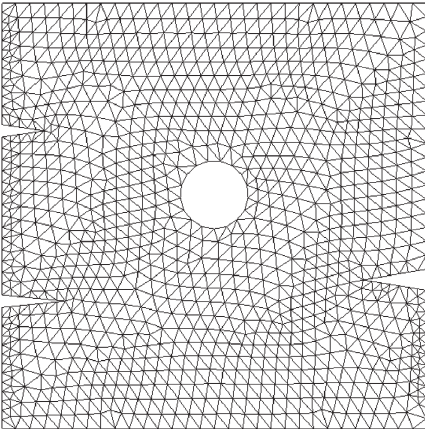
Figure 4: Initial mesh for the plate with a hole and three interacting